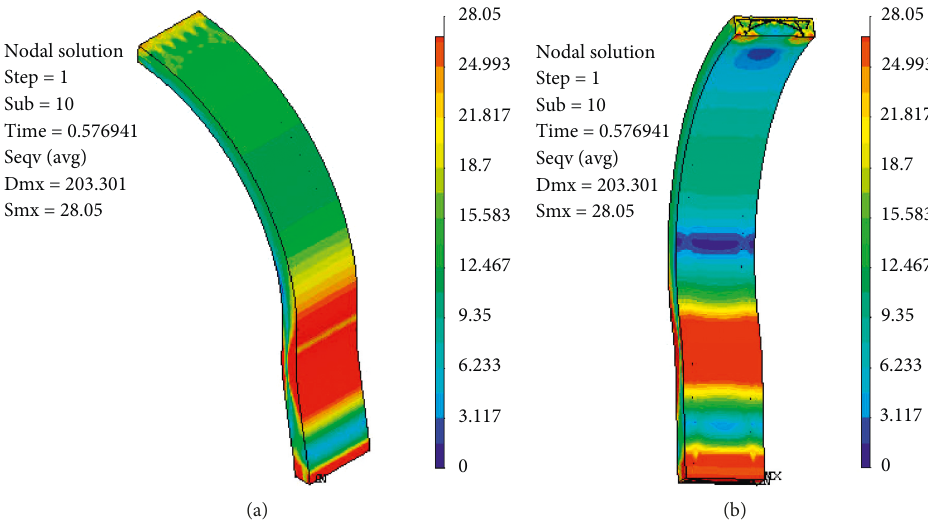
Figure 9: Stress distribution of the concrete. (a) the outer side and (b) the inner side of the